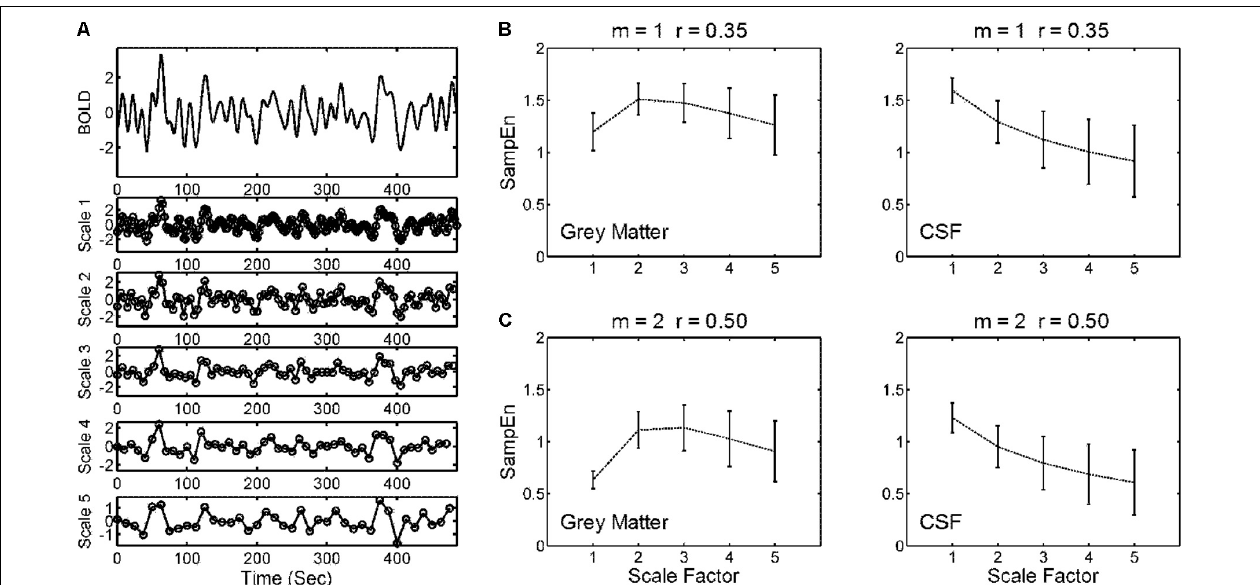
FIGURE 2 | Illustration of a multiscale sample entropy (SampEn; MSE) analysis. (A) Coarse-graining of a BOLD time series from a gray matter voxel of an individual was performed by averaging the data points within non-overlapping windows of increasing lengths of Scale Factors 1–5. Sample entropy for each scale factor was estimated from the coarse-grained time series. (B) Mean and 95% CI of MSE profiles across Scale Factors 1–5 from (left) all gray matter voxels and (right) all CSF voxels of the entire study cohort (354 subjects). The parameters for SampEn calculation were pattern length m = 1 and tolerance factor r = 0.35. (C) The same analysis as (B) but with distinct SampEn parameters ( m = 2, r = 0.50). The strategy was to explore a range of parameters that minimized the relative error of SampEn of BOLD signals in CSFs where minimal physiologic information was present, and to apply these parameters to calculate the SampEn of BOLD signals in gray matter